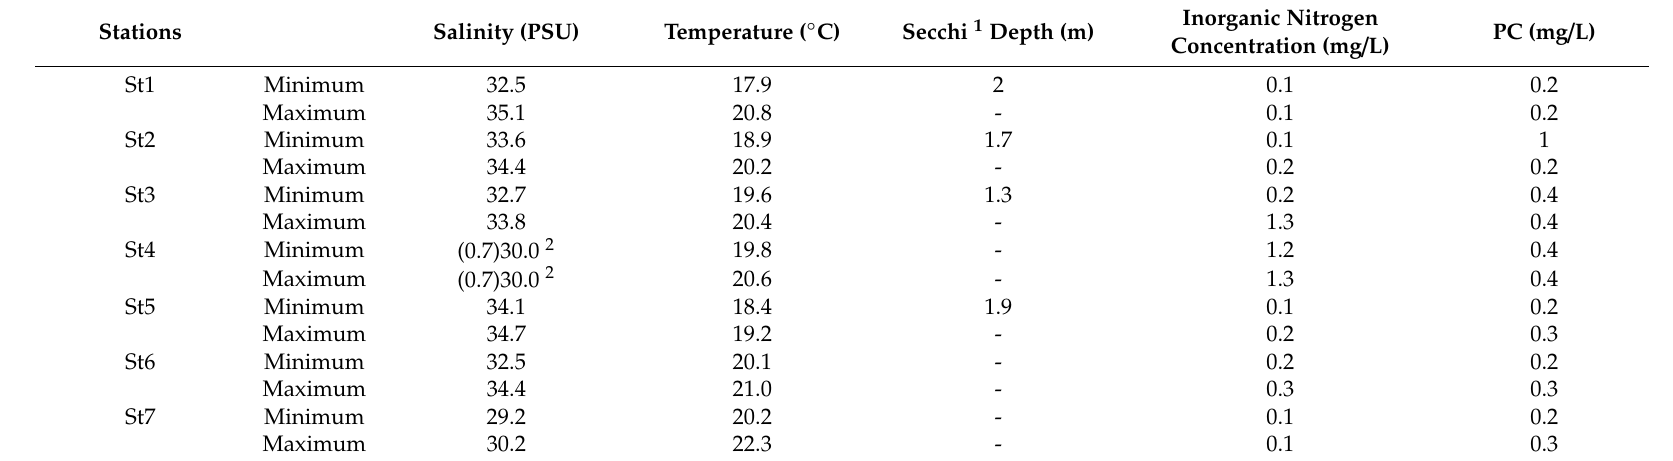
Table 2. Observed maximum and minimum values for the physical and biogeochemical state variables and for the main lagoon stations, for September 2000, according to data